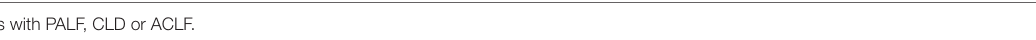
TABLE 1 | General principles in managing acute kidney injury in paediatric acute liver